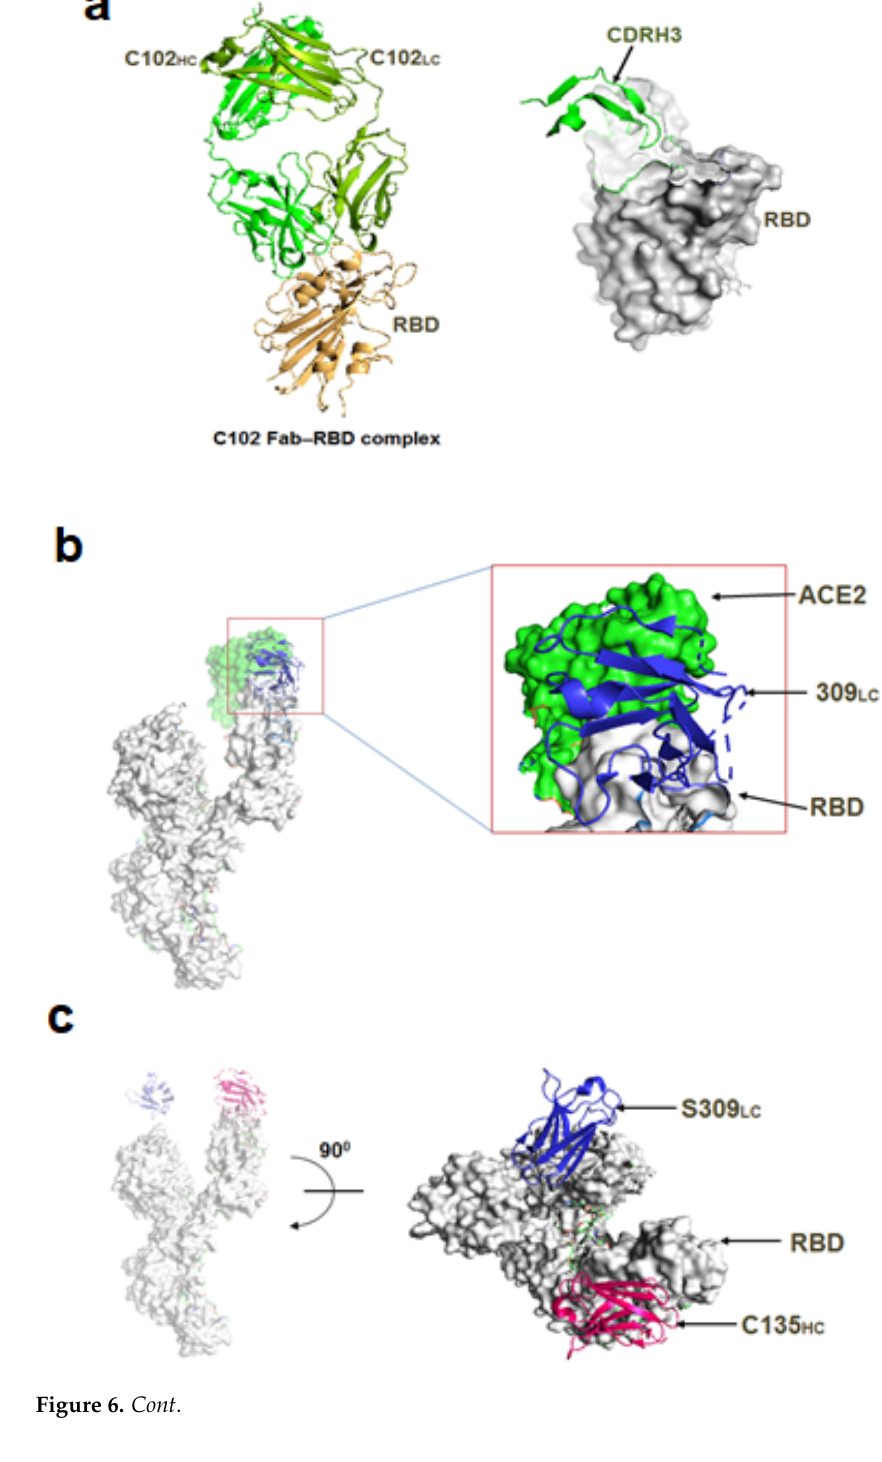
Figure 6. Different types of nAb based on structural and functional attributes. ( a ) Class I nAb (CDRH3) binds with open RBD (C102 Fab ‐ RBD complex). ( b ) Class II nAb S309 bind with both ACE2 and RBD (309LC ‐ ACE2 RBD complex). ( c ) Class III nAb C135 bind distinct RBD part (C135HC and S309LC with RBD). ( d ) Class IV nAb C135 bind with only up conformation of RBD (C135 HC and C135 LC with RBD). [PDB id: 6WPS, 7K8M]. iii. An additional class of nAb that hinders viral entry by occupying the outer surface of the ACE2; functional in both the up and down conformation of the RBD (Figure 6c). iv. The fourth class does not interact with the ACE2 receptor and is functional in the ‘up’ conformation of the RBD (Figure 6d) [37]. 3. Types of mAbs Remarkably, the beneficial antibodies being cloned in a laboratory need not come from humans but can be from definite animals also. Accordingly, mAbs are of four exten ‐ sive types. i. Murine : made from mouse proteins; names of drugs based on this end in ‐ omab. ii. Chimeric: a combination of mouse and human proteins; names of drugs based on this end in ‐ ximab. iii. Humanized: here, small doses of mouse proteins are attached to human proteins; names of drugs based on this end in ‐ zumab. iv. Human: these are fully human proteins; names of drugs based on this end in ‐ umab. 3.1. mAb in Treatment of COVID ‐ 19 The mAbs have been used to combat MERS, SARS, and other important infections caused by the corona family of viruses in the last decade. Since the COVID ‐ 19 pandemic broke out in early 2020, there has been an accelerated drive to use mAbs to fight the virus.